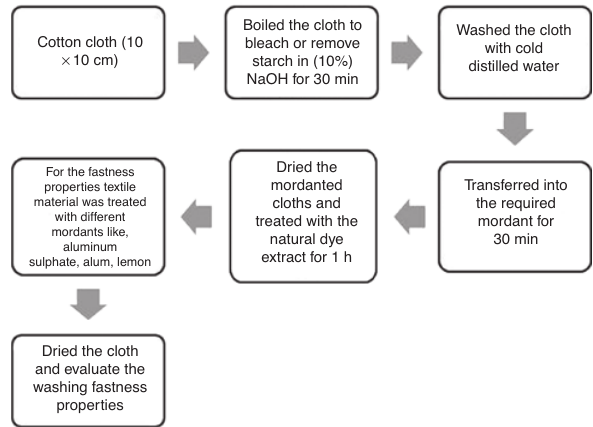
Figure 1: Flow chart showing the dying